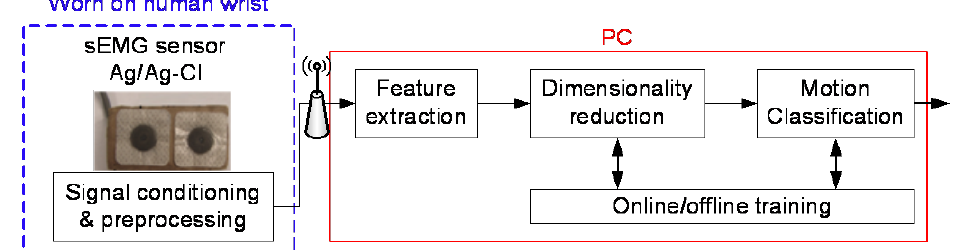
Figure 1. Configuration of the sEMG-based sensing system.